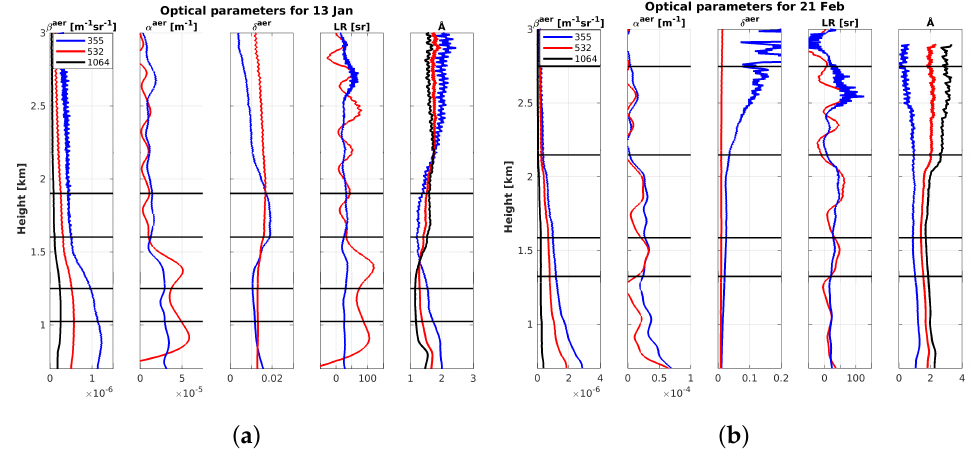
Figure 5. Profiles of the optical parameters for both case studies. The backscatter coefficient β aer , aerosol extinction α aer , aerosol depolarization δ aer , lidar ratio LR and Ångström exponents Å are shown. The Ångström exponent is shown for all wavelength pairs: Å(355, 532 ) in blue, Å(355, 1064) in red, Å(532, 1064) in black. The investigated altitude intervals are marked with black lines. ( a ) Parameters from 13 January (10:21–12:14)UT. ( b ) Parameters from 21 February